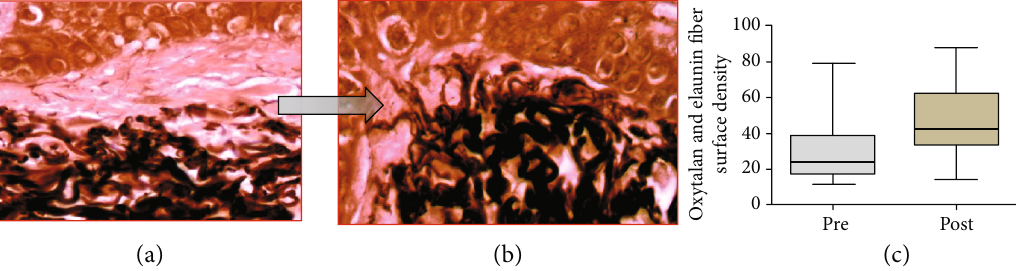
Figure 6: Photomicrographs representative of histological sections of biopsies before and after treatment with ADSCs. Changes in the pattern of zone 1 in copies (a) and (b) (oxidized orcein). (a) Pretreatment biopsy showing rare oxytalan fi bers in zone 1. (b) Posttreatment biopsy shows a high density of perpendicular thin oxytalan fi ber web stained: oxidized orcein. (c) Graphical representation of the surface density of oxytalan fi bers in zone 1 ( p = 0 : 0001 ).